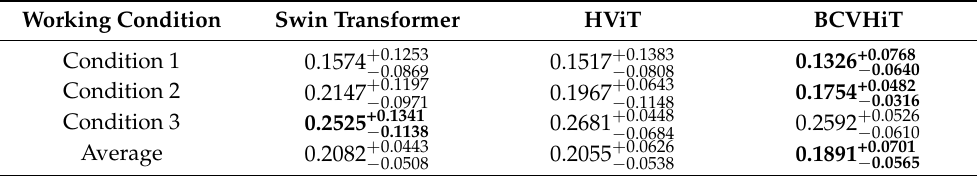
Table 6. Statistical results of ablation experiment under the different working conditions in Test 1. Working